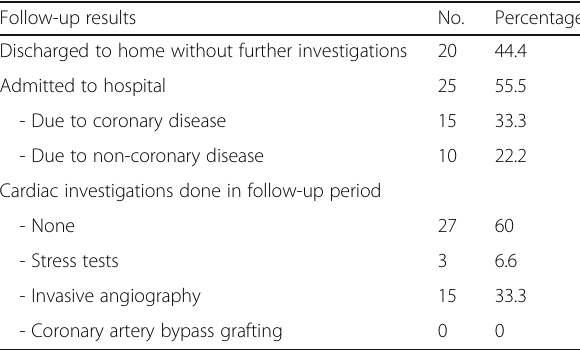
Table 7 Our follow-up results Follow-up